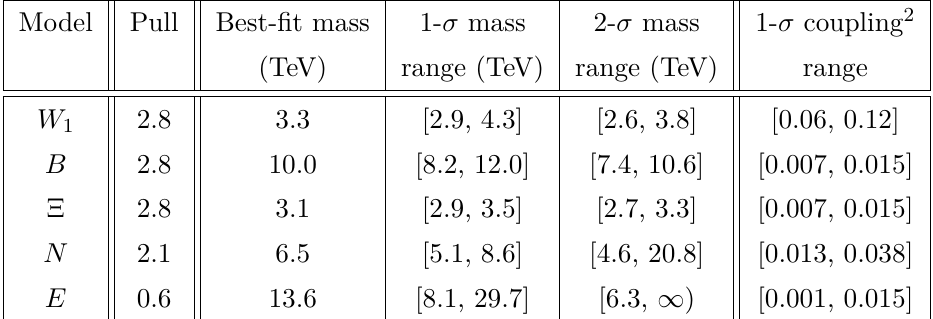
Table 5 . As table 4, but applying the PDG recommendation [32] for rescaling the stated uncertainties when combining measurements that are only poorly